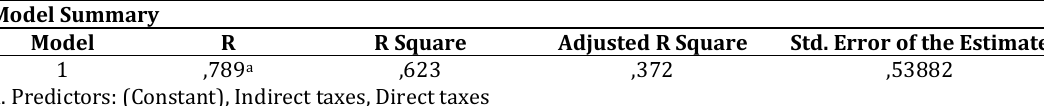
Table 6: OLS Regression – Model